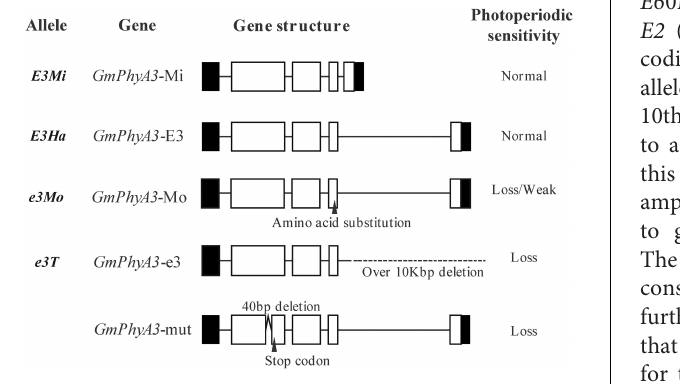
FIGURE 4 | The allelic variation of the E3 gene. Open boxes, shaded boxes, and horizontal lines, respectively indicate exons, untranslated regions (UTRs), and introns of protein structure. Variations such as deletion, insertion, and presence of the stop codon are indicated. On the right side are shown their photoperiod sensitivity.